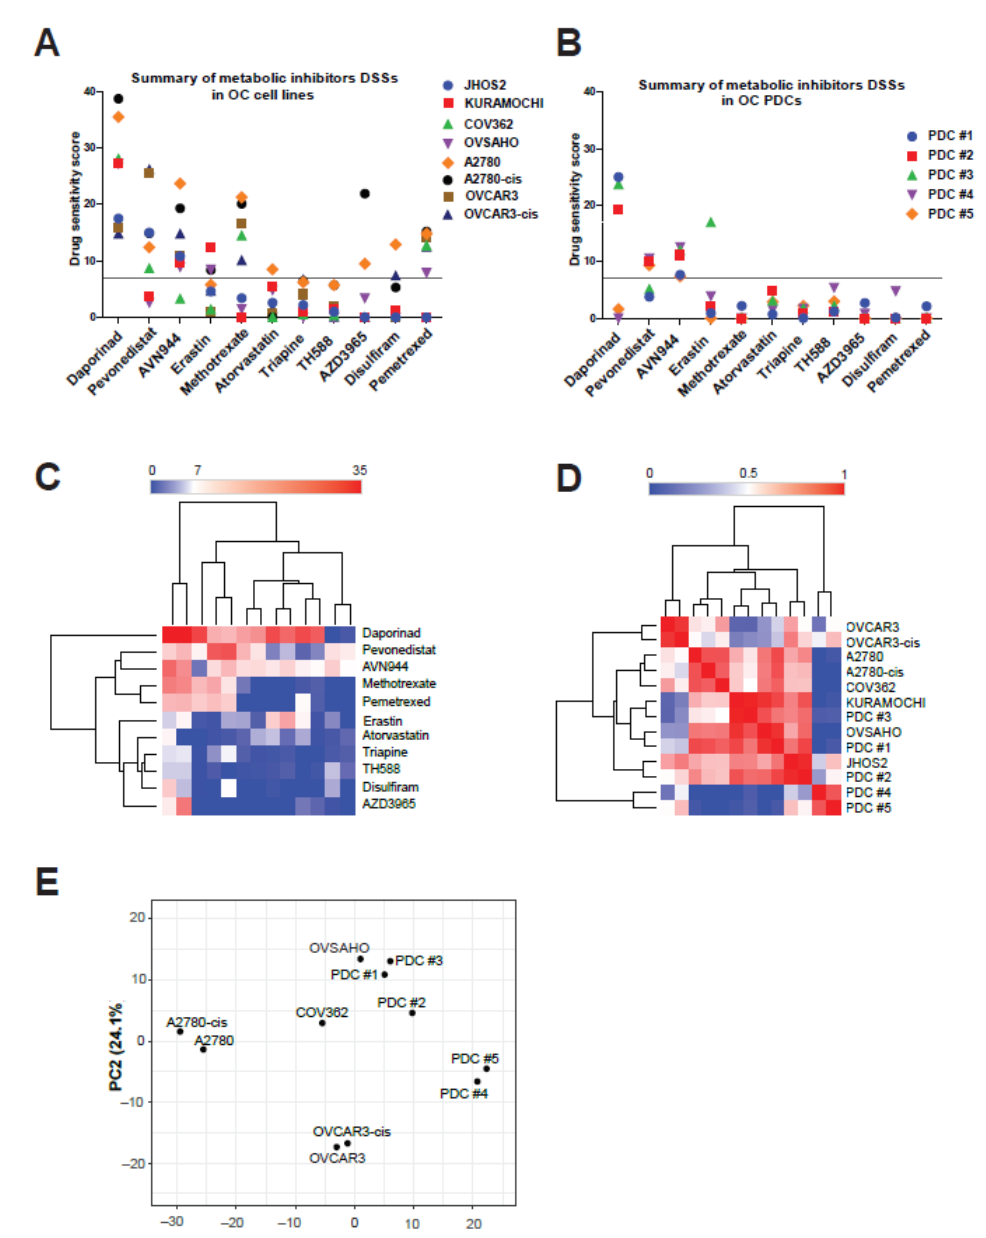
Figure 3. Evaluation of drug responses for anti-metabolic drugs ( n = 11) in OC cell lines and PDCs. Comparison of DSS values for anti-metabolic drugs in OC cell lines ( A ) and PDCs ( B ). An arbitrary threshold of DSS 7 was chosen, as it indicates a moderate drug cytotoxicity. Analysis of drug responses based on hierarchical clustering ( C ), similarity matrix ( D ) and PCA plot ( E ) of combined DSS values from OC cell lines and PDCs (from patients #1 to #5).